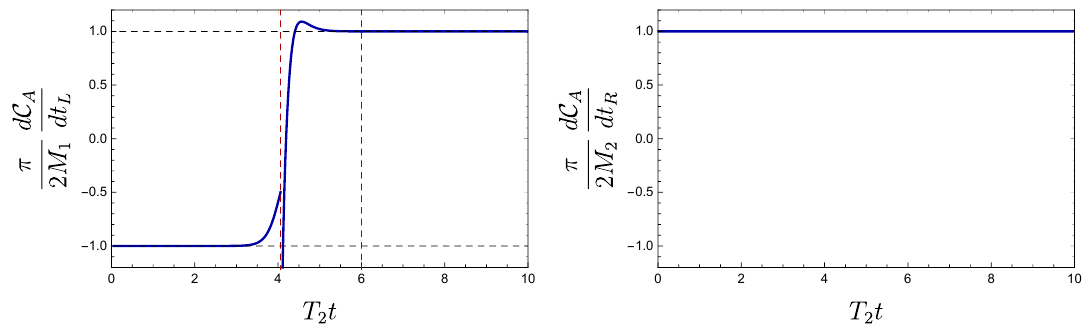
Figure 23. The time evolution of complexity using the CA proposal for d = 2. In the left panel, we (cid:12)x t R = 0 and evolve t L , while in the right panel, we (cid:12)x t L = 0 and evolve t R . In both cases, we have used w = 1 + 10 (cid:0) 5 , t w T 2 = 6 and in the left panel ~ ‘ ct = 1. The vertical red lines in the left panel indicate the critical times at which r m leaves the past singularity and later, when r b enters the future one. For the right boundary time evolution, since the shock wave is sent early enough, r s is already very close to r h; 2 and the (cid:13)at pro(cid:12)le is due to the fact that (cid:12)xing t L = 0 means that r m stays behind the past singularity.